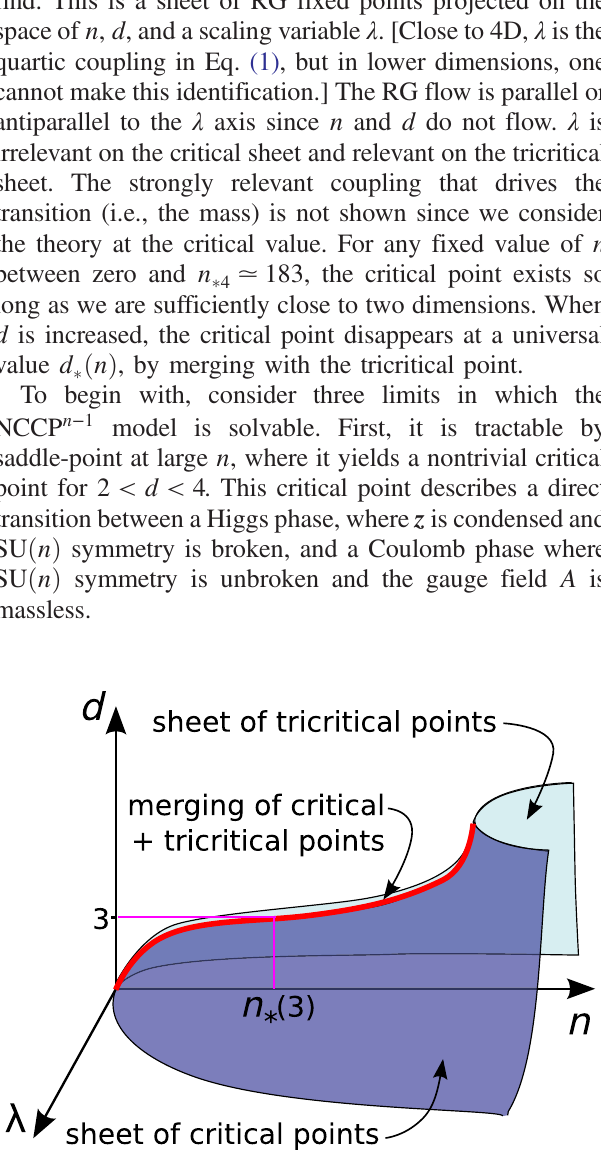
FIG. 19. Topology of the sheet of RG fixed points for dimen- sionalities around three (the limiting cases d ¼ 2 and d ¼ 4 are not